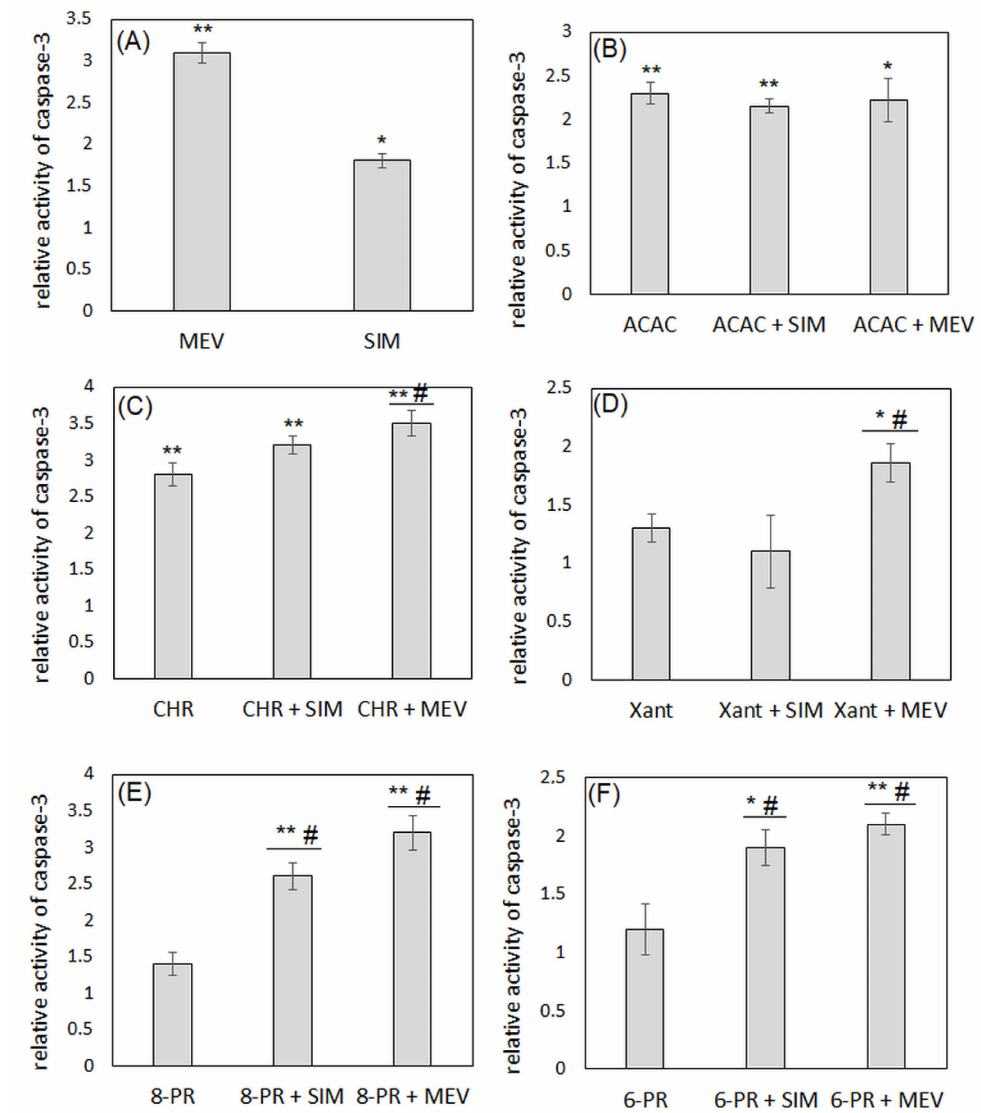
Figure 5. The activity of caspase-3 in Jurkat T cells incubated for 48 h with simvastatin (SIM), mevas- tatin (MEV) ( A ), flavonoid (acacetin, ACAC; chrysin, CHR; xanthohumol, Xant; 8-prenylnaringenin, 8-PR; 6-prenylnaringenin, 6-PR), and flavonoid in combination with statin (SIM or MEV) ( B – F ). Each column represents the mean relative activity of the enzyme normalized to the control derived from non-treated cells. The results were the means ± SDs from three independent experiments. The statistical significance was determined using Student’s t -test. We compared the results obtained for each compound/combination with the results obtained from the samples containing no compounds (* p < 0.05; ** p < 0.001). We also determined the differences between results obtained for single flavonoid and its combination with statins (# p < 0.05; # p <